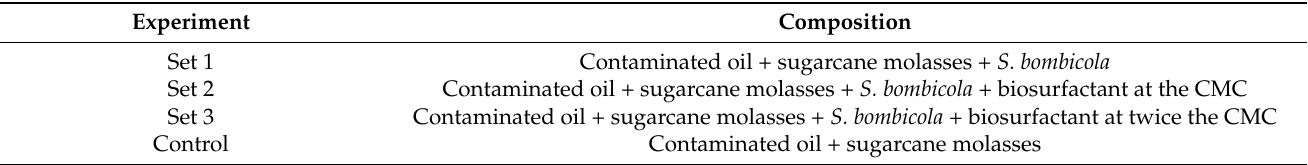
Table 1. Formulated mixtures for motor oil biodegradation experiments. CMC = critical micelle concentration.